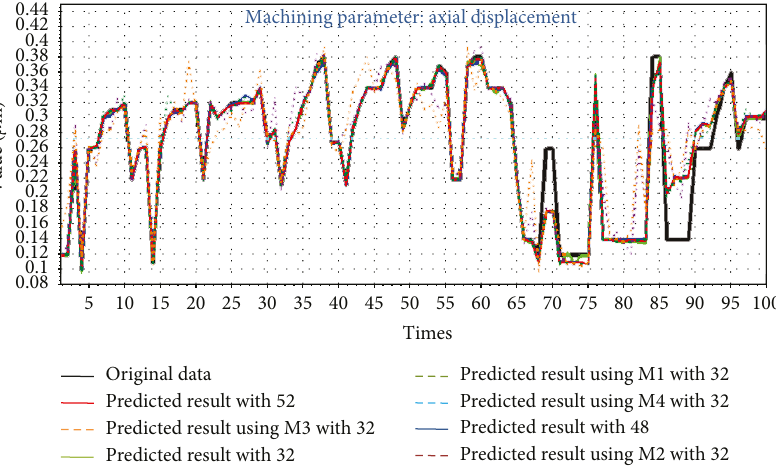
Figure 17: Predicted results of axial displacement of grinding